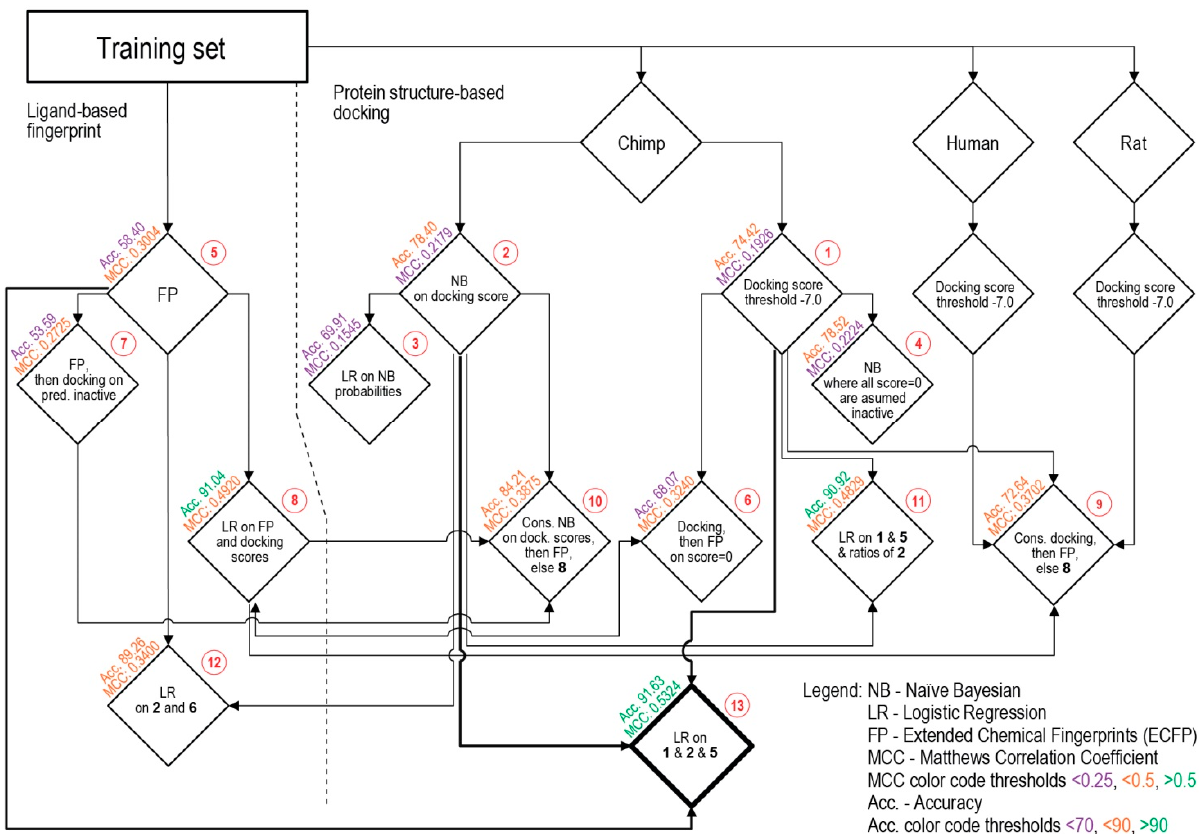
Figure 3. Flowchart of the different Procedures ( 1 – 13 , see Section 3.2 in text) applied on the training set. A first attempt at separation used a threshold on the docking scores in order to classify compounds into binding and non-binding. Different values were tested, with the best being a threshold score value of − 7 kcal/mol. Compounds with scores above this level were classified as non-binders, and scores below this level were classified as binders (Figure 3: Procedure 1 ). Despite the fact that the Acc. value is relatively good, the MCC value is the lowest of all the tested Procedures (Table 1). Naïve Bayesian classifiers were constructed with the docking scores of both active (binding) and inactive (non-binding) compounds, resulting in mean values of μ = − 8.91 and − 5.97 kcal/mol, and standard deviations (SD) = 1.94 and 2.01, respectively. The results of using only this classifier on its own are shown in Table 1: Procedure 2 .